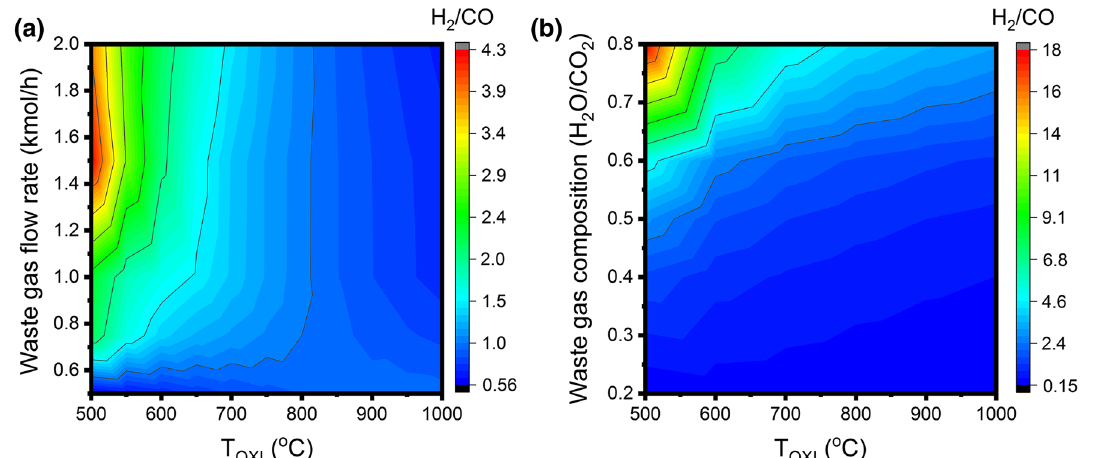
Fig. 7 Impact of the variation of the waste gas flow parameters and temperature on the H 2 /CO yield ratio in the oxidation reactor: a varia- tion of flow of waste gas with an equimolar mixture of CO 2 and H 2 O;